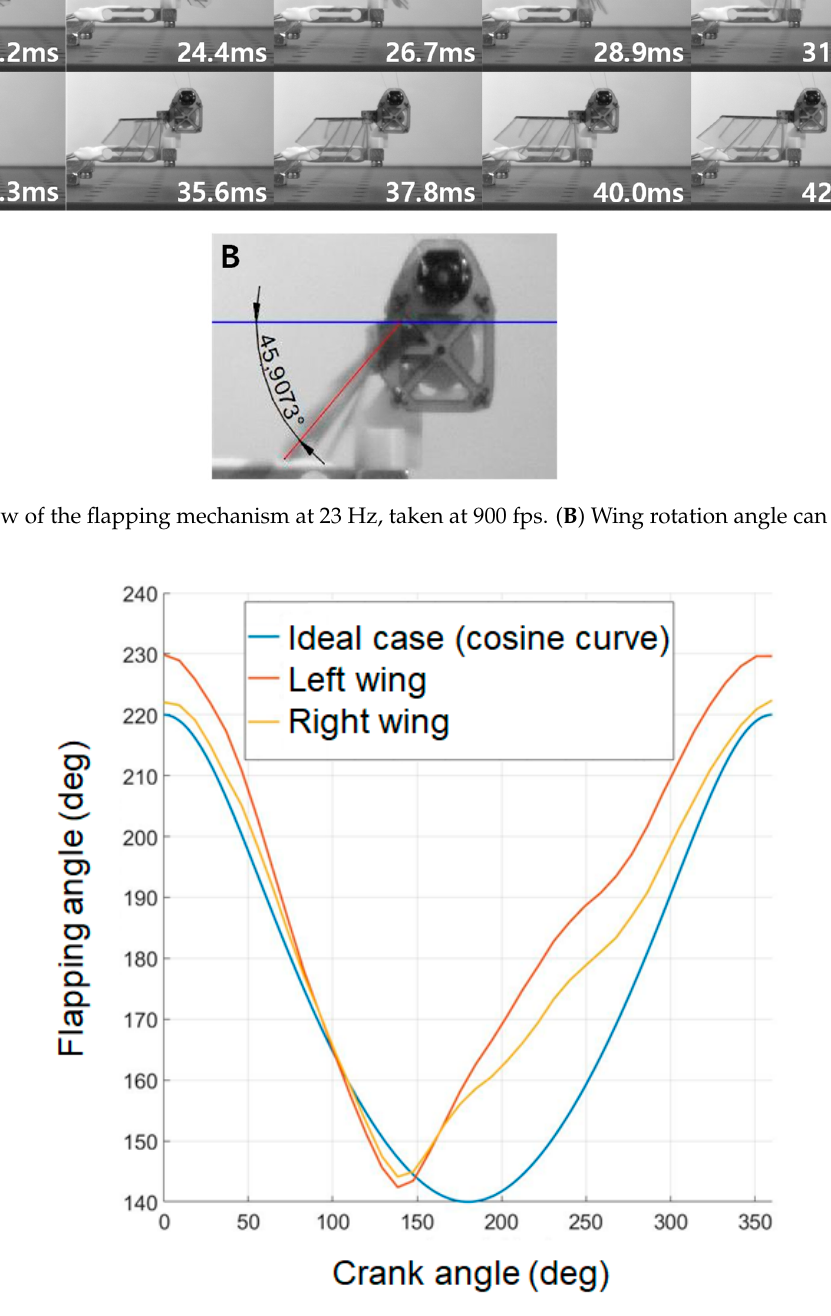
Figure 10. Comparison of flapping angle between the experimental case and the ideal case.